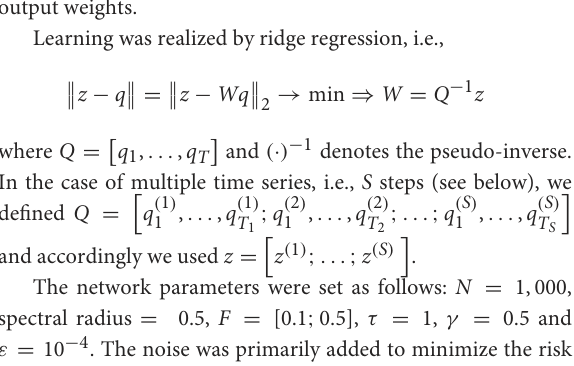
algorithm during walking and running can be found in Figure 2. One sample difference between the events based on the measured and predicted vertical GRF waveforms equaled ∼ 7ms due to the relatively low sampling frequency, common to wearable